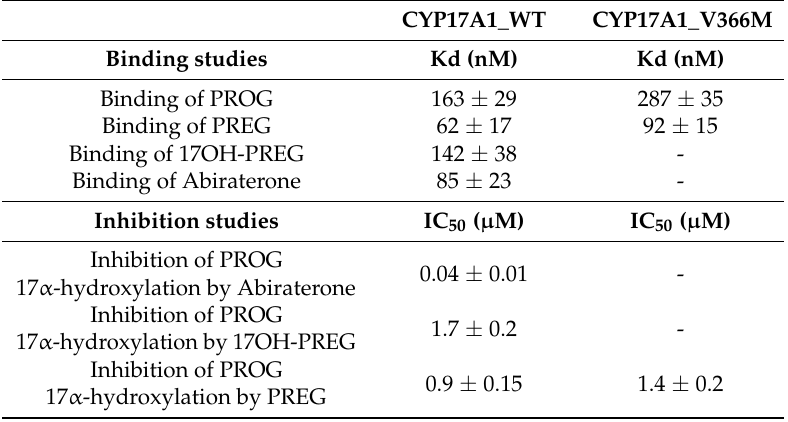
Table 5. Binding and inhibition studies of WT and the V366M mutant of CYP17A1